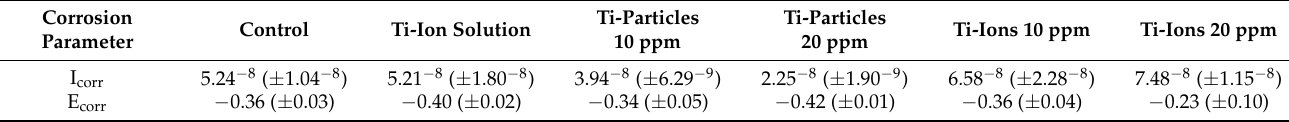
Figure 3. ( a ) Representative potentiodynamic curves from which the current density (I corr ) and the corresponding potential (E corr ) were obtained. ( b ) Mean and standard deviation of I corr values of all groups. ( c ) Mean and standard deviation of E corr of all groups. Table 1. Mean and standard deviation of I corr (in A/cm 2 ) and E corr (in V) of the study groups. Corro-